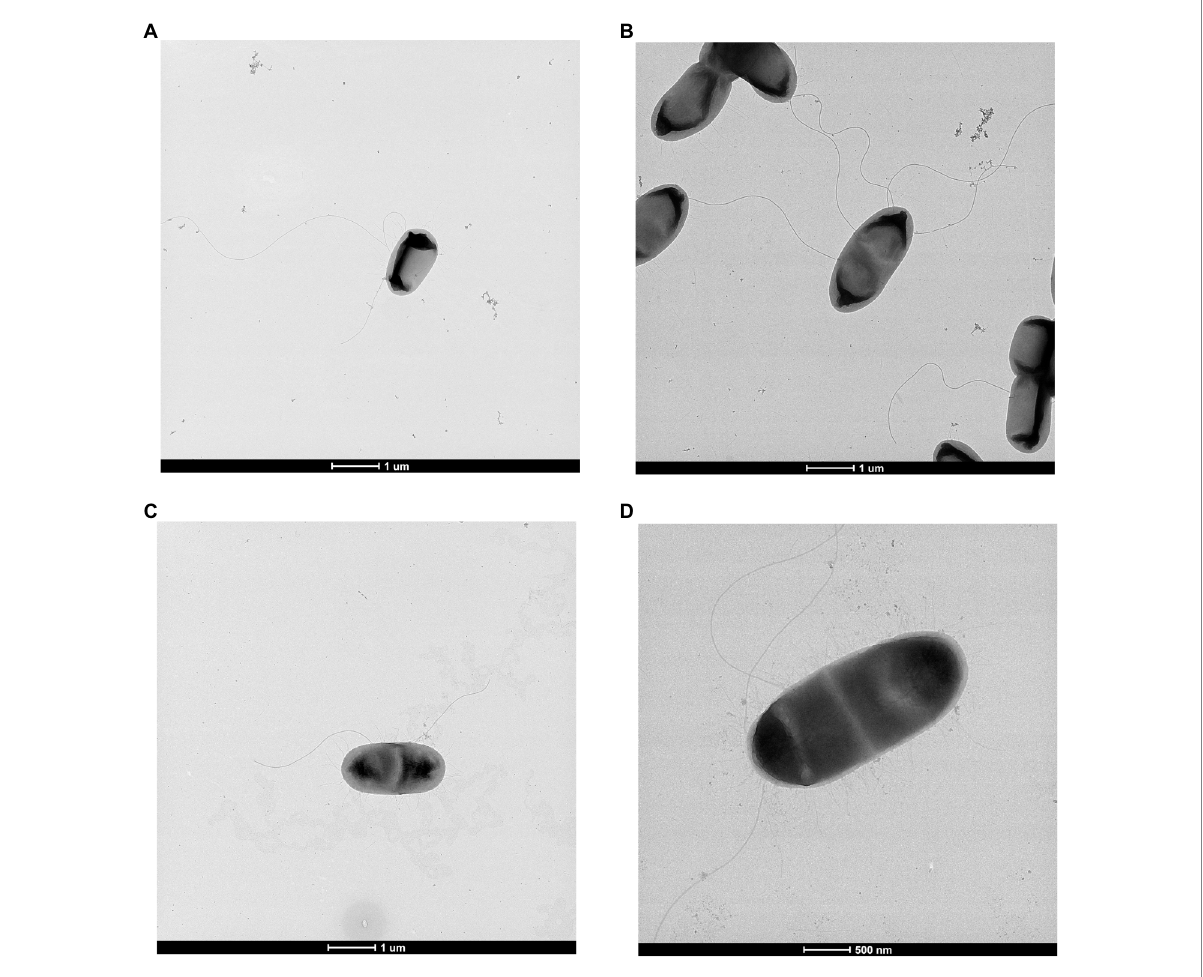
FIGURE 3 Transmission electron microscopy of (A) Scandinavium goeteborgense CCUG 66741 T , (B) Scandinavium manionii sp. nov. H17S15 T , (C) Scandinavium hiltneri sp. nov. H11S7 T and (D) Scandinavium tedordense sp. nov. TWS1a T displaying their peritrichous flagella arrangement. Scale bar, 1 μ m and 500 μ